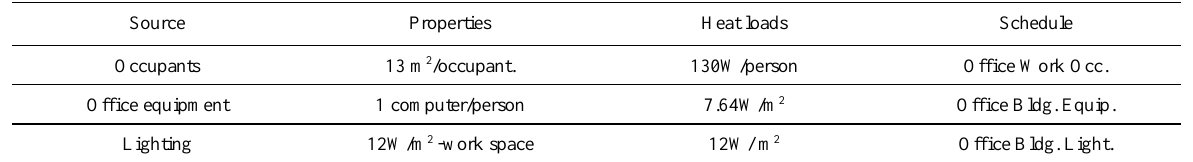
Table 4. Internal heat loads-office